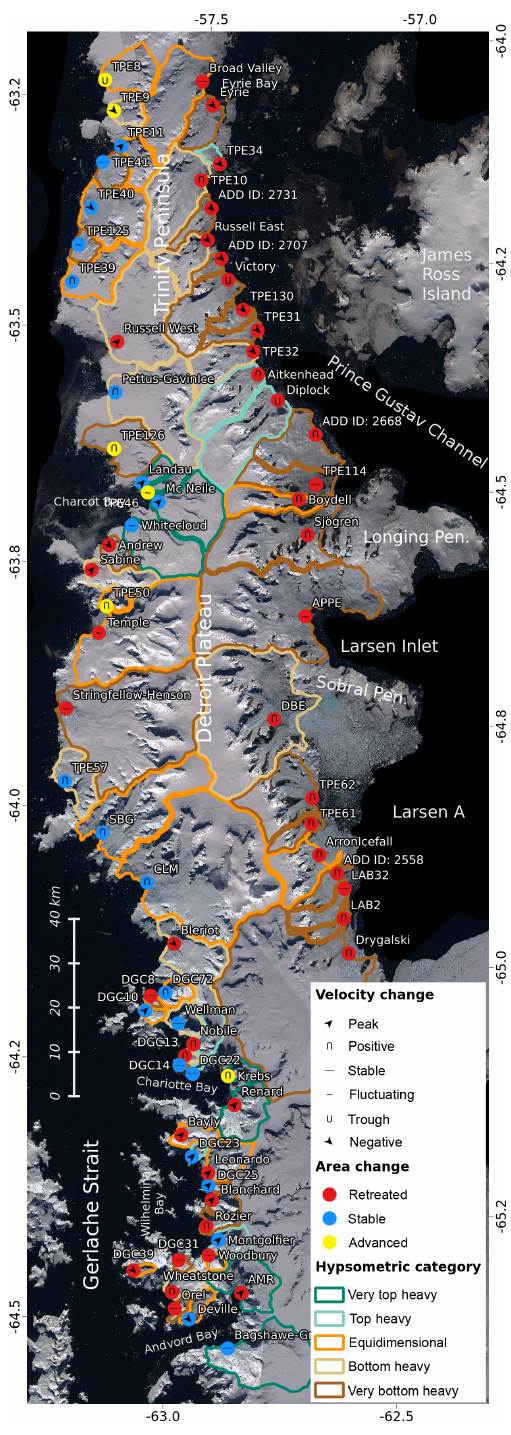
Figure 3. Categorizations of glaciers based on the temporal varia- tions of area changes (dots) and flow velocities (symbols). Colors of catchment delineation indicate hypsometric categories according to Jiskoot et al. (2009). Background: Landsat LIMA Mosaic USGS, NASA, BAS,